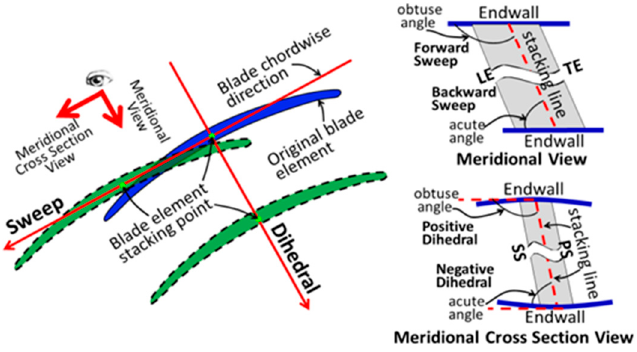
Figure 1. Definitions of 3D blade design in the orthogonal coordinates.